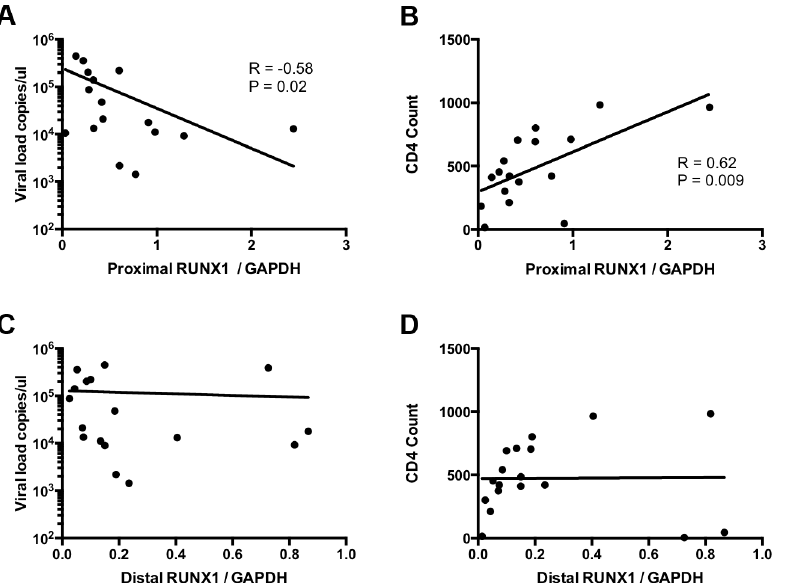
Figure 5. RUNX1 expression in memory CD4 + T-cells correlates with clinical metrics in patients. CD4 + memory T-cells were sorted from total PBMC of viremic HIV-1 patients in the absence of therapy. RNA extract from these cells was used to measure the expression of promoter proximal and distal RUNX1 as normalized to GAPDH. Expression level were then graphed as follows: A ) promoter proximal RUNX1 vs viral load, B ) promoter proximal RUNX1 versus CD4 + T-cell count, C ) promoter distal RUNX1 versus viral load and D ) promoter distal RUNX1 versus CD4 + T-cell count. R and P values were computed using Spearman test.